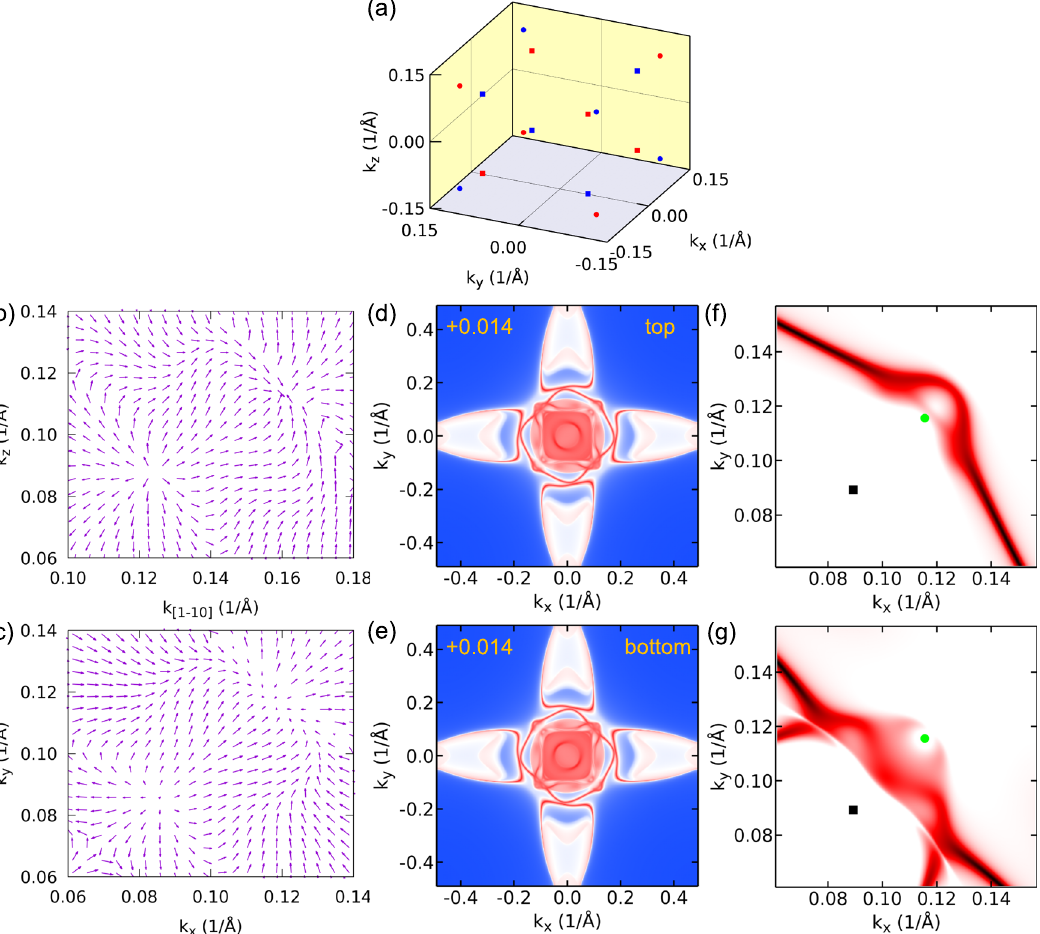
Fig. 5 Weyl points (WPs) in NdBi 3q. a Locations of the two sets of 16 WPs with the momentum-energy of (± 0.0875, ± 0.0875, ± 0.0875 1/Å, E F + 12.6 meV) and (± 0.1133, ± 0.1133, ± 0.1133 1/Å, E F + 14.9 meV), respectively, where E F is the Fermi energy. Berry curvature near the WP pair on the ( b ) vertical k xy - k z plane and ( c ) horizontal k x - k y plane at k z = 0.10. Surface Fermi surface near the WP energy at E F + 0.014 eV on the ( d ) top and ( e ) bottom (001) surfaces. The corresponding surface-only contributions zoomed on the ( f ) top and ( g ) bottom (001) surface with the locations of the WP projections labeled by the black square and green